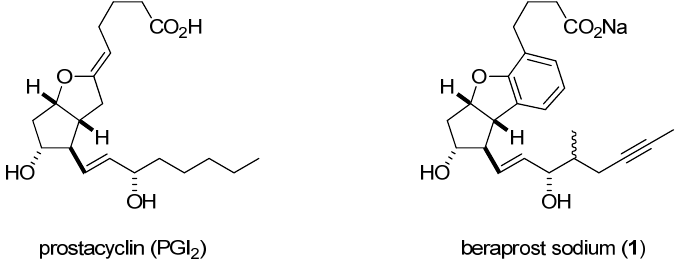
) and beraprost sodium ( 1 ). 2